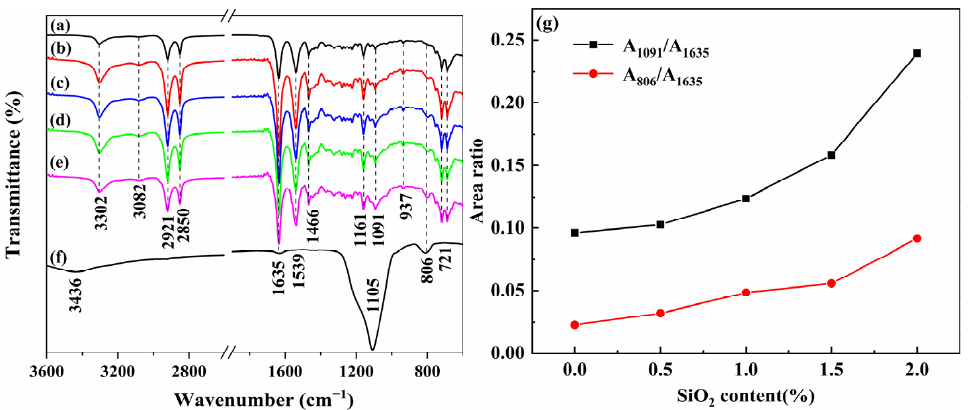
Figure 7. FTIR spectra of PA11 and PA11/SiO 2 composites: ( a ) PA11, ( b ) PA11/0.5% SiO 2 , ( c ) PA11/1.0% SiO 2 , ( d ) PA11/1.5% SiO 2 , ( e ) PA11/2.0% SiO 2 , ( f ) SiO 2 , ( g ) A 1091 /A 1635 and A 806 /A 1635 ratios of FTIR peak areas.